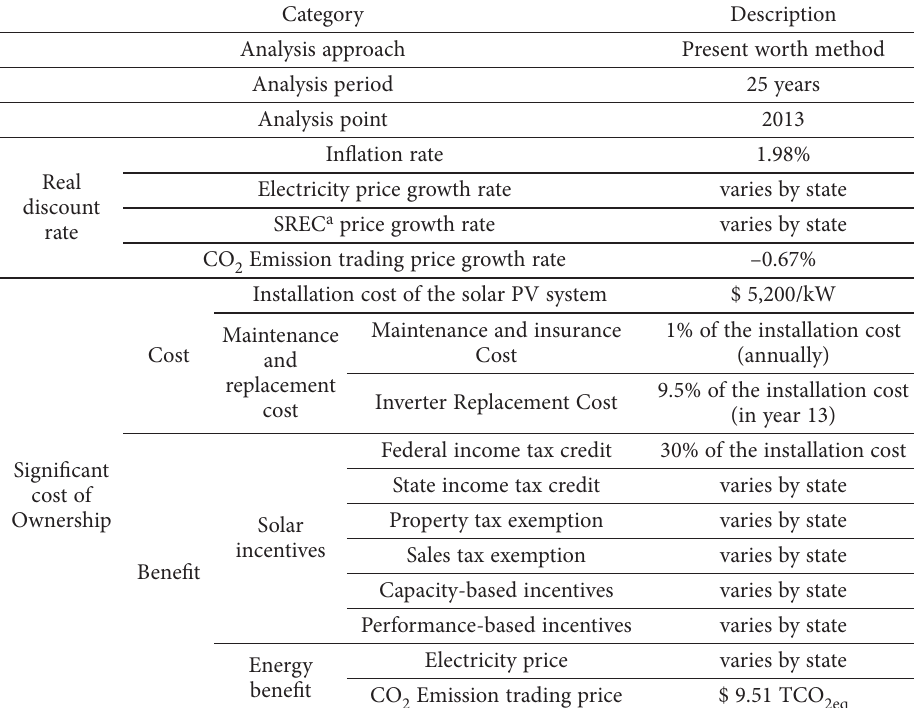
Table 2. Assumptions for LCC and LCCO